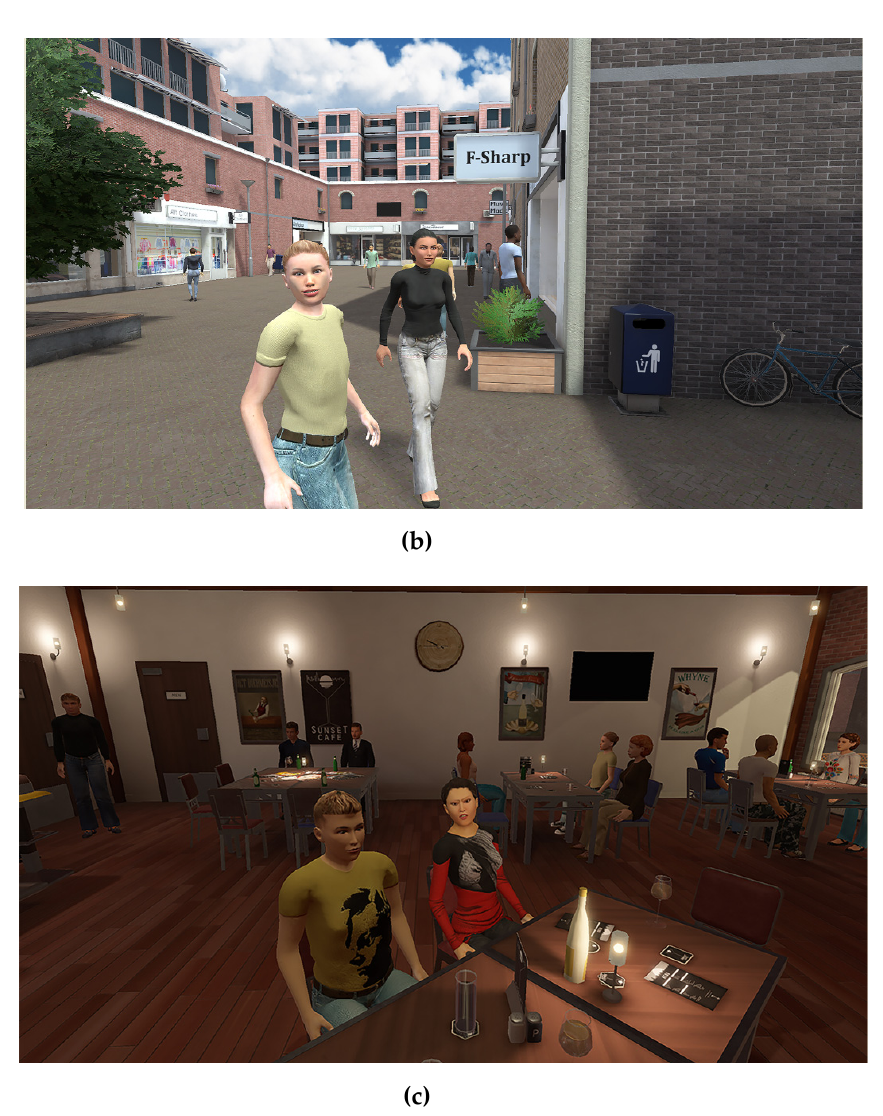
Figure 3. Virtual environments: supermarket (a), shopping street (b), and café (c). Source: CleVR BV, Delft, The Netherlandd.